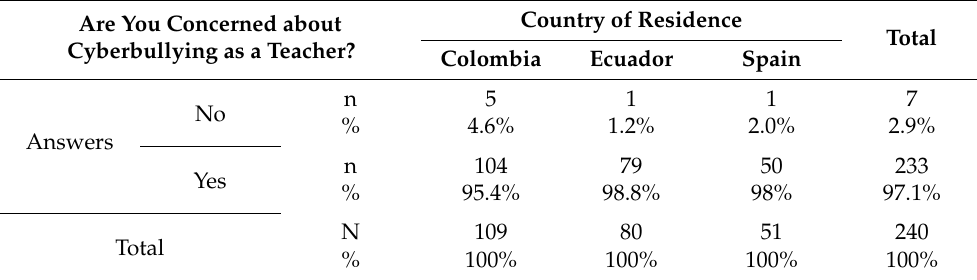
Table 8. Cross-categorization of the variable “Are you concerned about cyberbullying as a teacher?” and the variable “Country of Residence”.